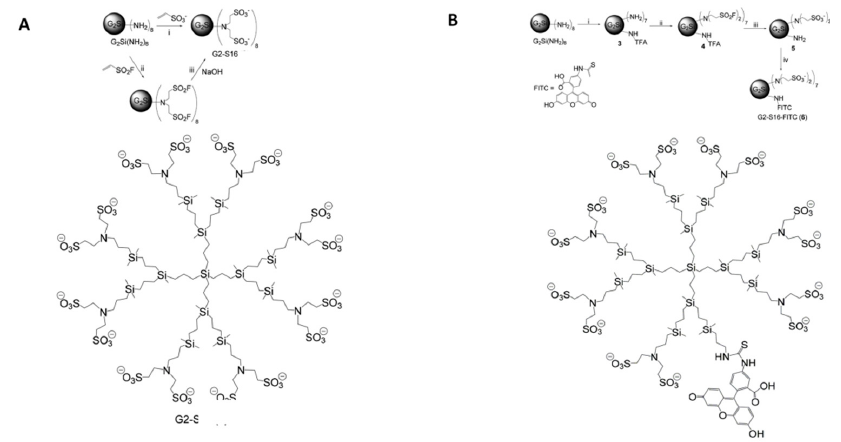
Figure 6. Schematic synthesis route and molecular representation of dendrimers. ( A ) G2-S16 with silicon core and 16 sulfonate end groups and ( B ) G2-S16-FITC with silicon core and 14 sulfonate end groups and FITC molecule were represented. The generation of dendrimers is determined by considering that each generation corresponds to the number of repeating layers of silicon atoms. Images adapted from Gutierrez-Ulloa et al.